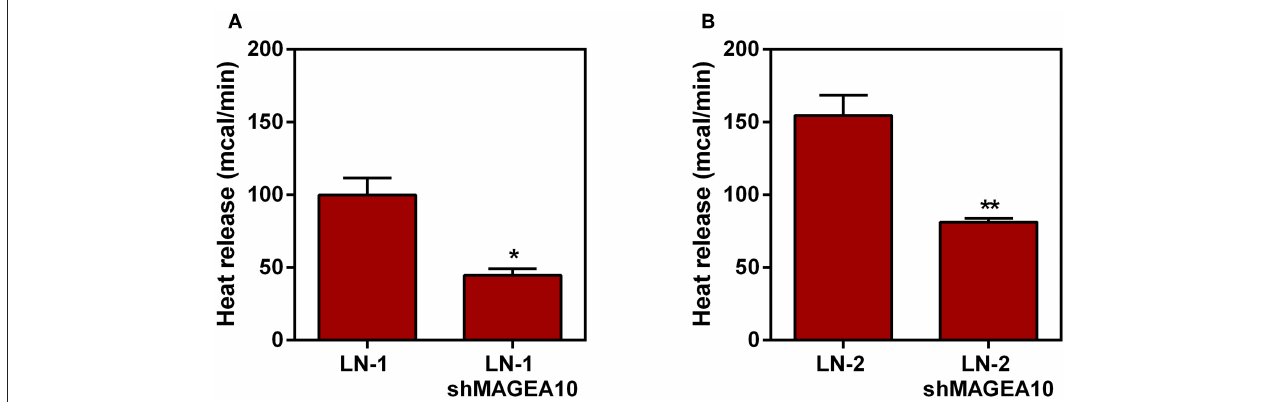
FIGURE 2 | Heat release by human oral squamous carcinoma cells LN-1 and LN-2 suppressed for MAGEA-10 expression (shMAGEA10). The bars represent the release of total heat of living cells in 35min of experiment. (A) LN-1 and LN-1 shMAGEA10 cells; (B) LN-2 and LN-2 shMAGEA10 cells. Values were expressed as mean ± SEM. * p < 0.05; ** p < 0.01.